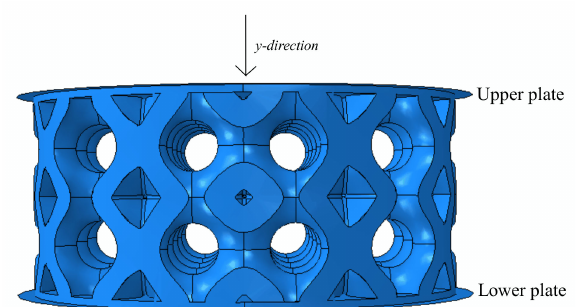
Figure 8. Analytical rigid plates and preferential direction